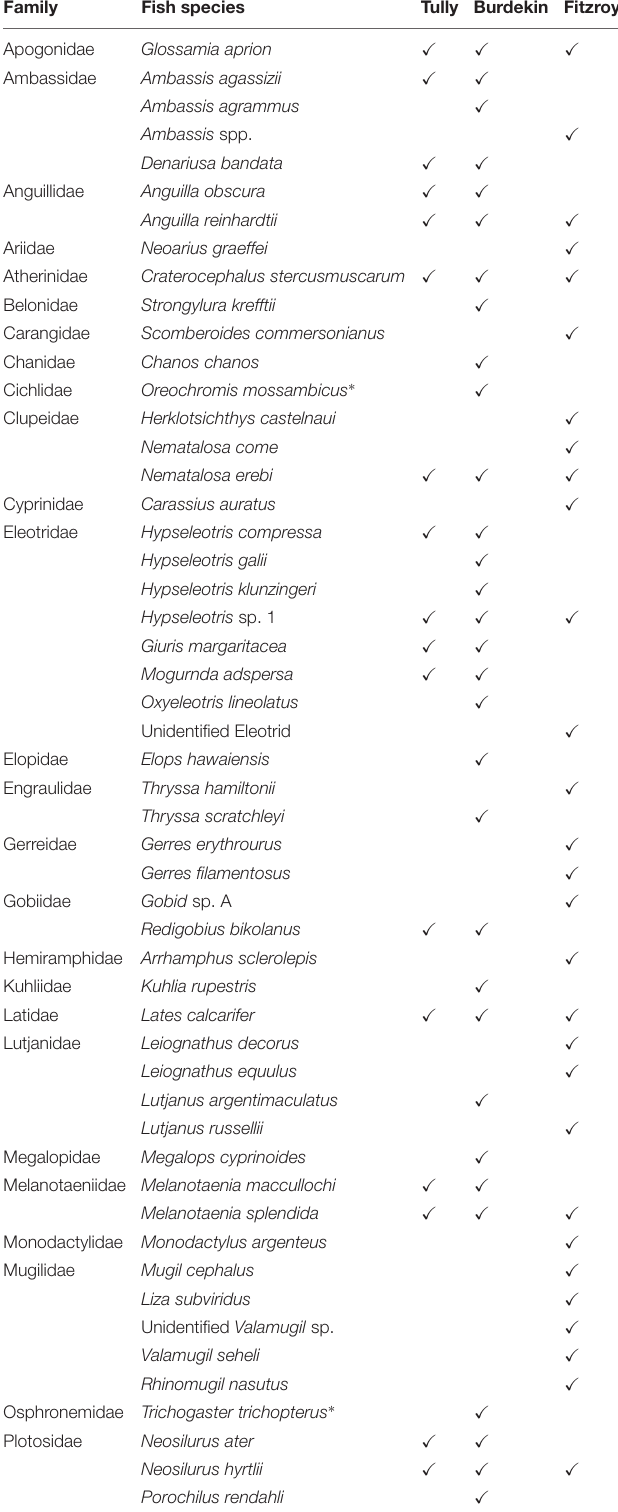
TABLE 1 | Fish species recorded from GBR coastal floodplain wetlands in the three study regions. Family Fish